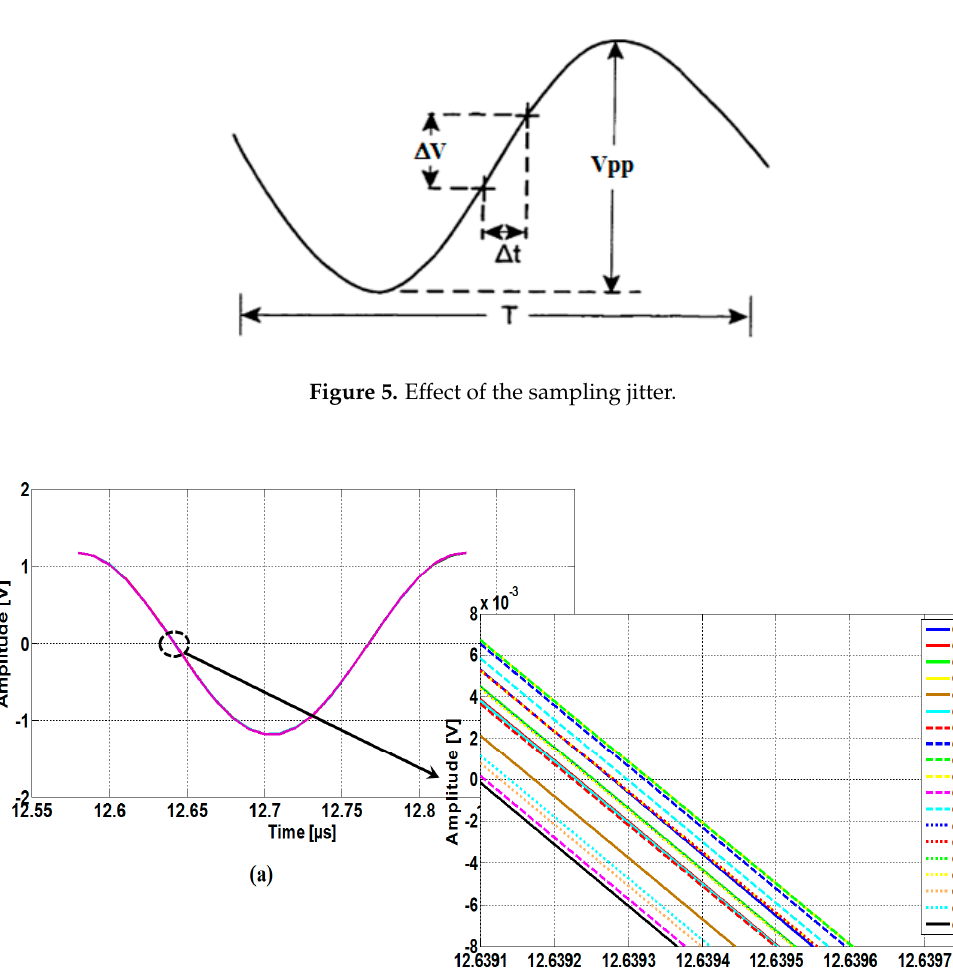
Figure 6. Cycle-to-cycle jitter around zero-crossing: ( a ) last 19 periods of the transmitted signal superimposed upon each other; ( b ) Magnified view around zero-crossing.